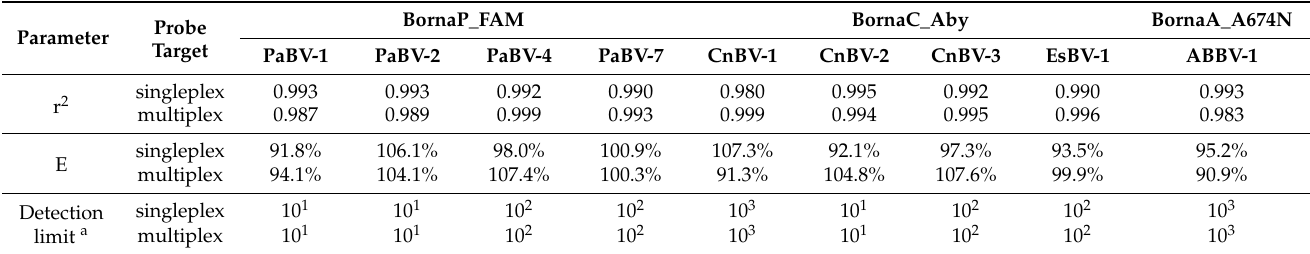
Table 2. Real-time RT-PCR assays: Sensitivity and regression analyses of standard curves. Parameter Probe